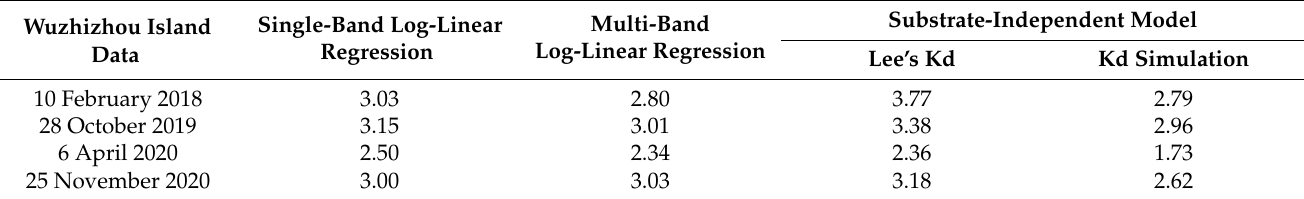
Table 9. Comparison of inversion bathymetry results of remote sensing images by different models using Wuzhizhou Island. Units: m.